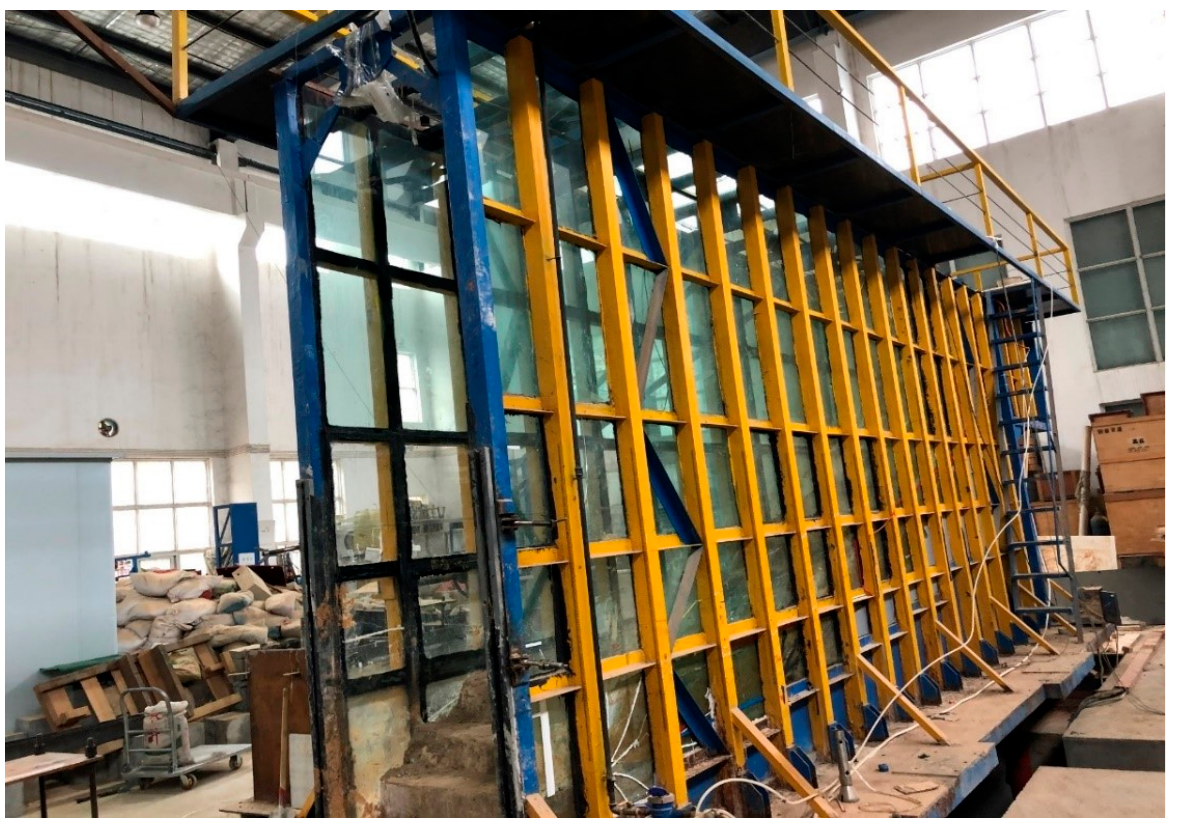
Figure 6. Platform for the landslide model test. Table 1. Material properties of the landslide body.